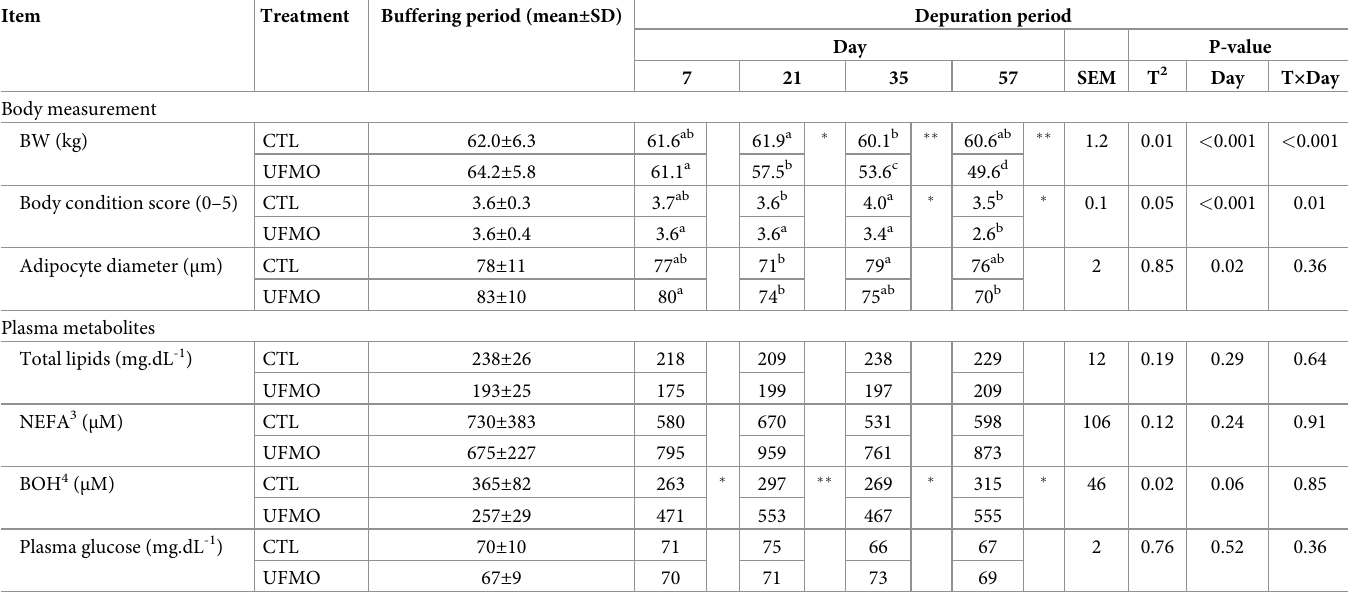
Table 3. Intakes, body measurements and plasma metabolites concentrations of ewes groups 1 .